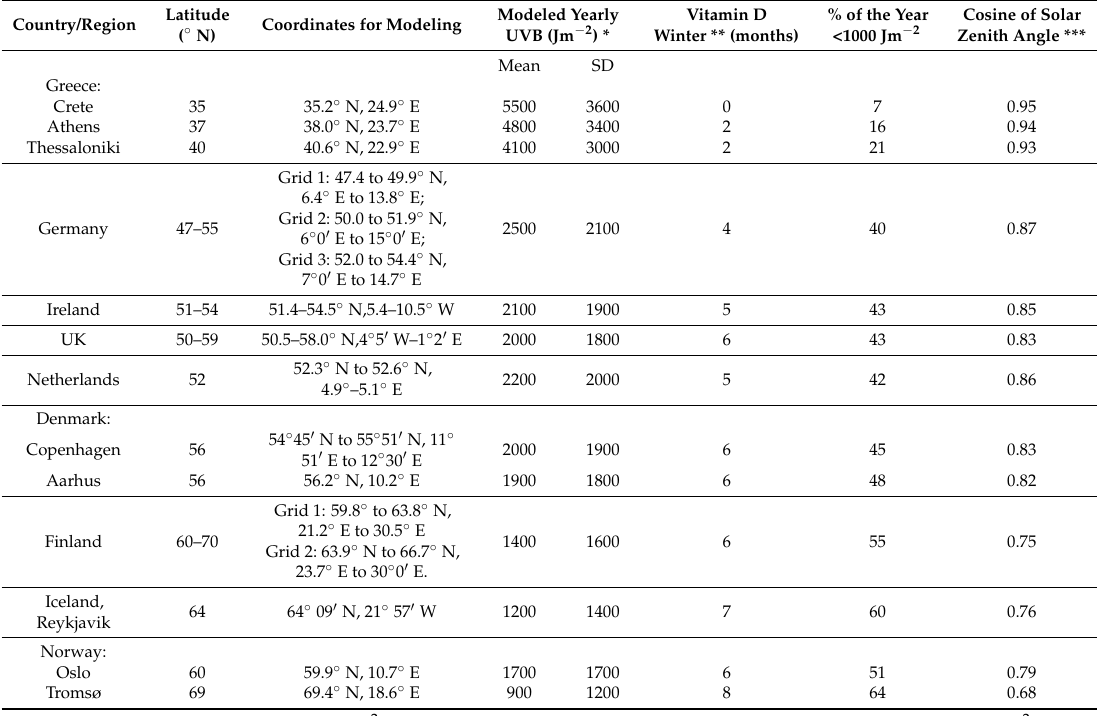
Table 1. Modeled mean yearly ultraviolet B (UVB) doses, duration of vitamin D winter, proportion of a typical year with UVB doses less than 1000 Jm − 2 and cosine of solar zenith angle over a 10 year period (2003–2012) at selected European countries and